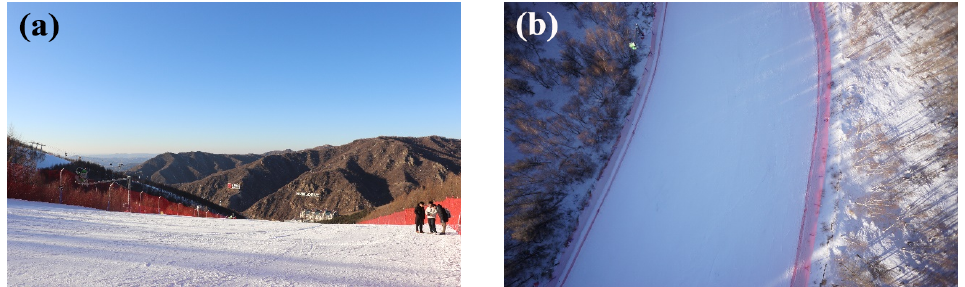
Figure 1. Collection point cloud datasets in the ski resort: ( a ) shows the environmental conditions of the Wanlong ski resort at the time of collection; ( b ) is an aerial picture taken during acquisition. The seven ski tracks of Wanlong ski resort are all made of extremely hard artificial snowPlease verify meaning is retained. The environment of the snow field is relatively complex, including not only five main snow tracks, but also two training tracks, as well as trees, riprap, etc. A DJI M600 PRO UAV was used as the flight platform with LiDAR because of its excellent stability and flight performance, and the fact that its battery life can reach 30 min. In the acquisition process, the scanning frequency was 550 KHz, the overlap rate of sidebands was 20 percent, the flight altitude was 110 m, the flight speed was 5 m/s, and we conducted four flight scanning missions in